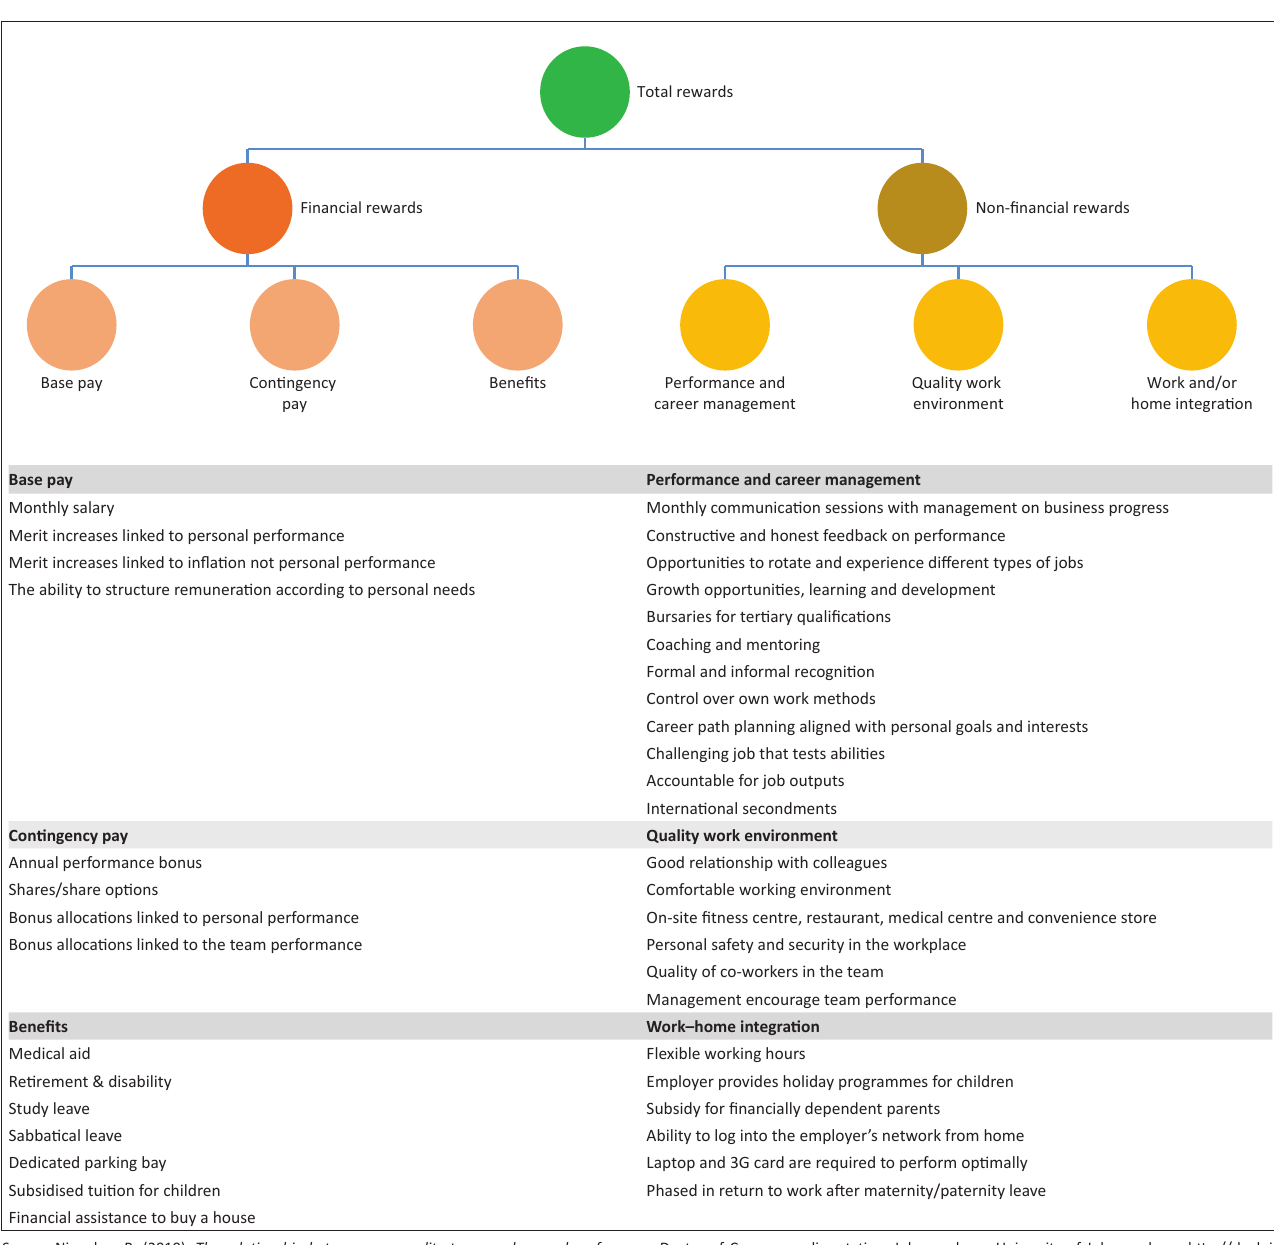
FIGURE 1: Nienaber’s total reward preference